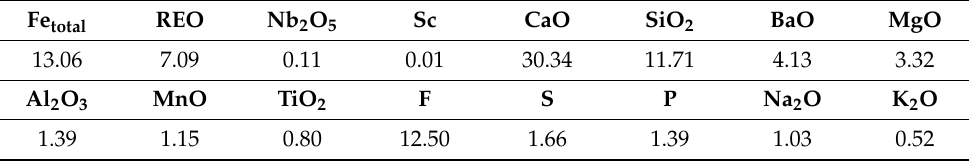
Table 1. Chemical composition of the tailing sample